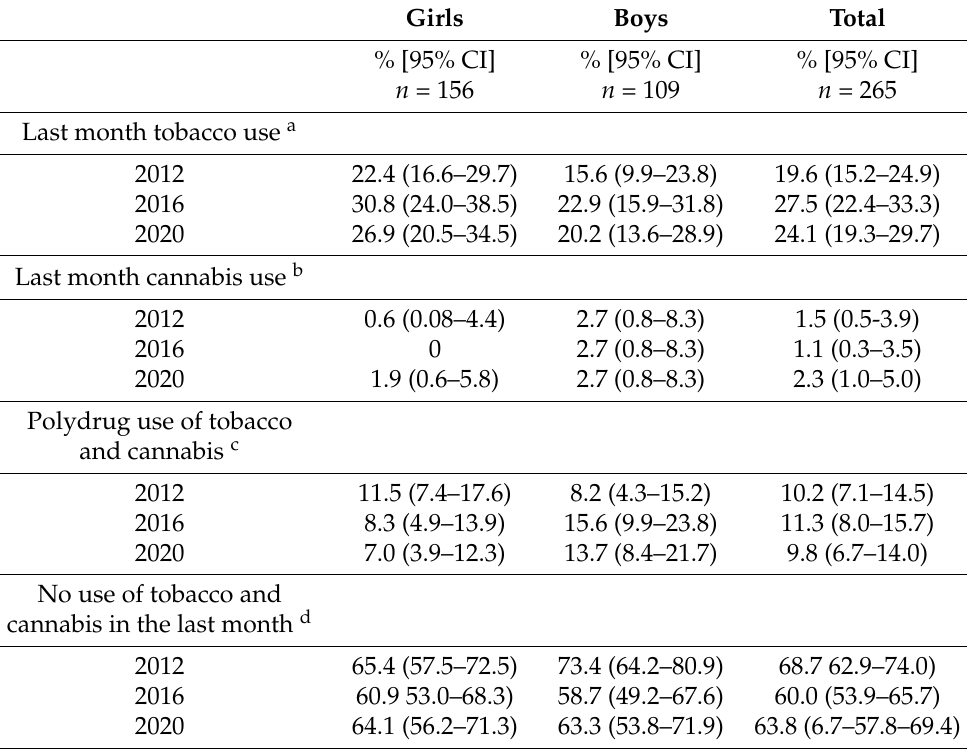
Table 1. Prevalence of exclusive use according to substance consumed (last month tobacco use, last month cannabis use, polydrug use of tobacco and cannabis and no use of tobacco and cannabis in the last month), sex and year. Cohort